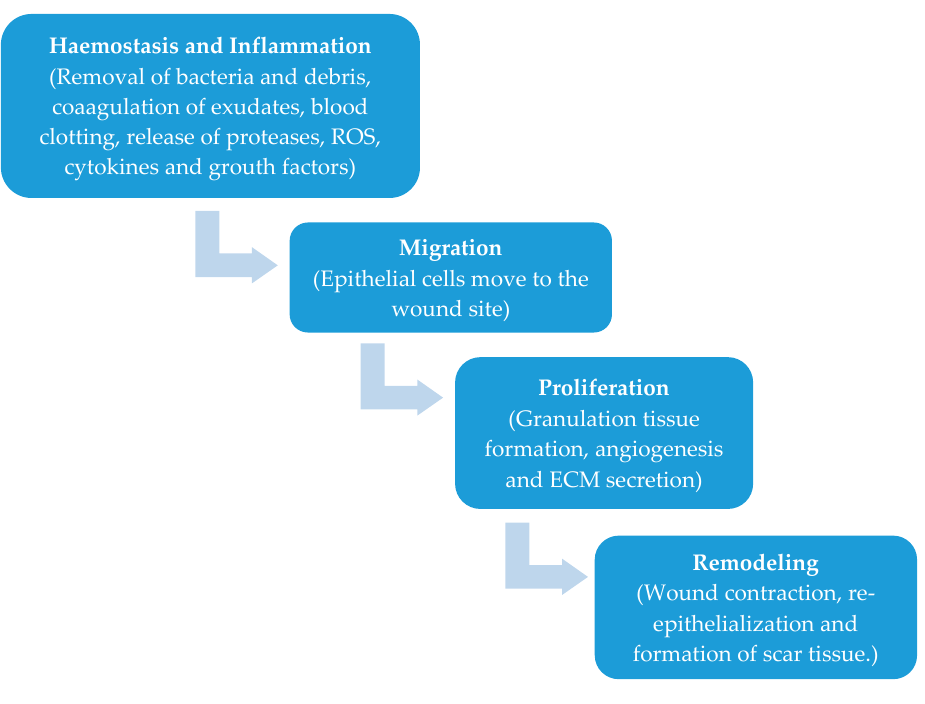
Figure 4. Films for wound dressing.